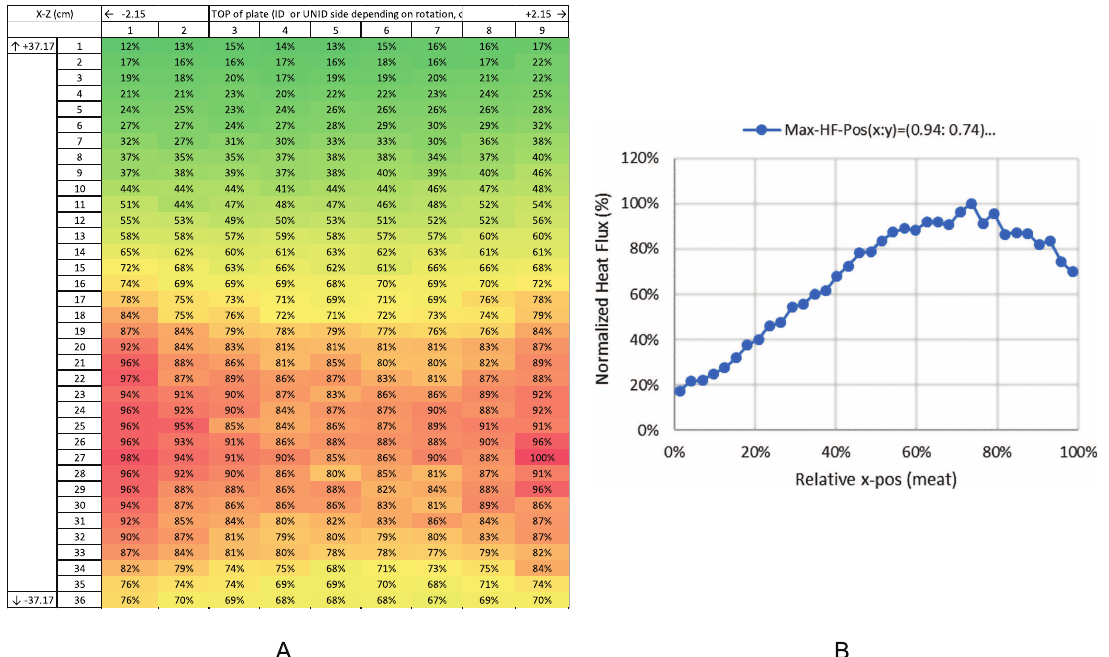
Fig. 3. (A) Example of calculated BR2 heat flux distribution at BOC (normalized, full plate) and (B) length distribution at the maximum location.